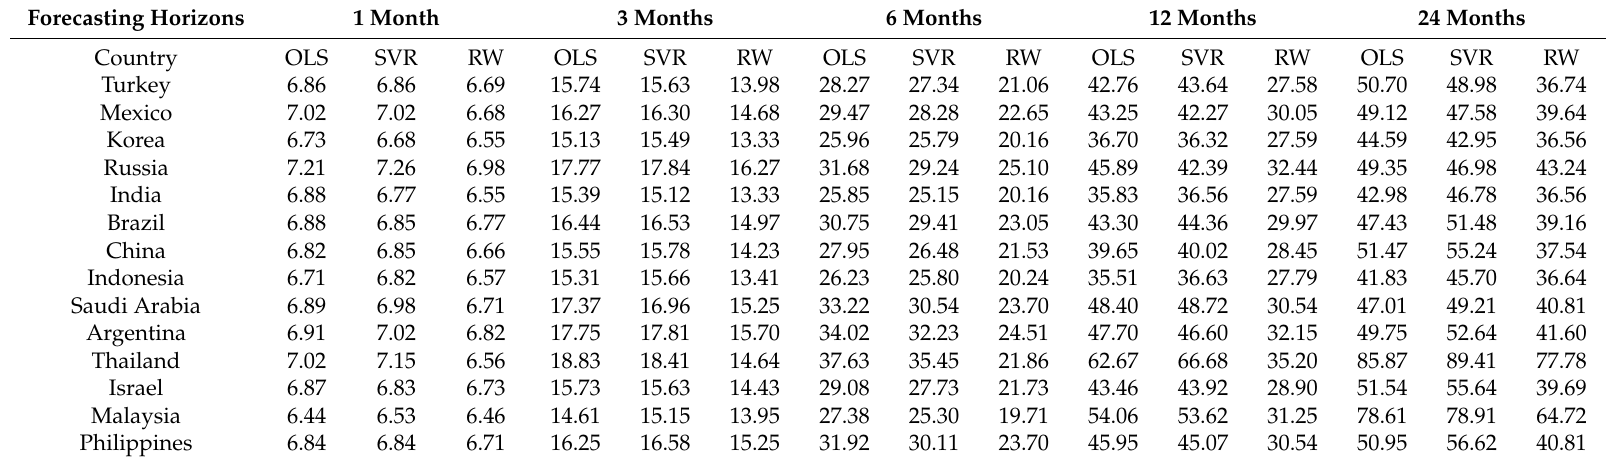
Table 2. Oil prices out-of-sample forecasting